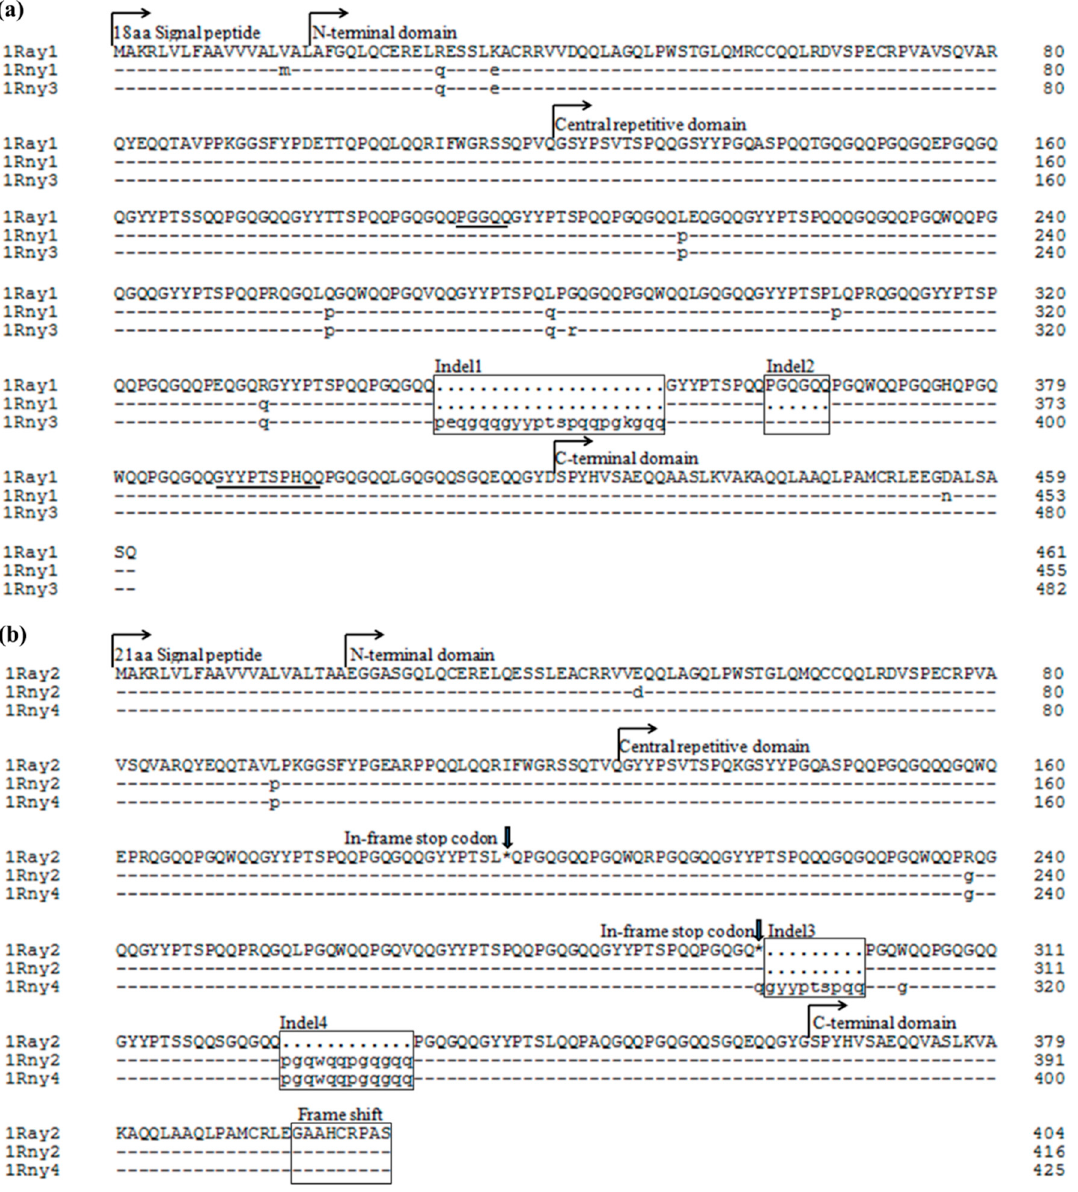
Figure 3. Comparison of the deduced amino acid sequences of Rny1, Rny3, and Ray1 ( a ); and Rny2, Rny4, and Ray2 ( b ). The irregular repeat motifs are underlined, indels and frame shift region are boxed, and in-frame stop codons are marked by solid arrows.